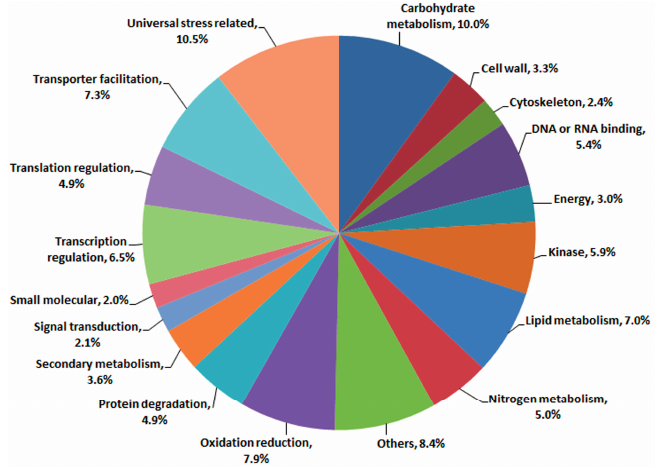
Figure 2. Functional categorization of all annotated and differentially expressed genes. This analysis was based on annotated genes, not including genes classified as “unknown